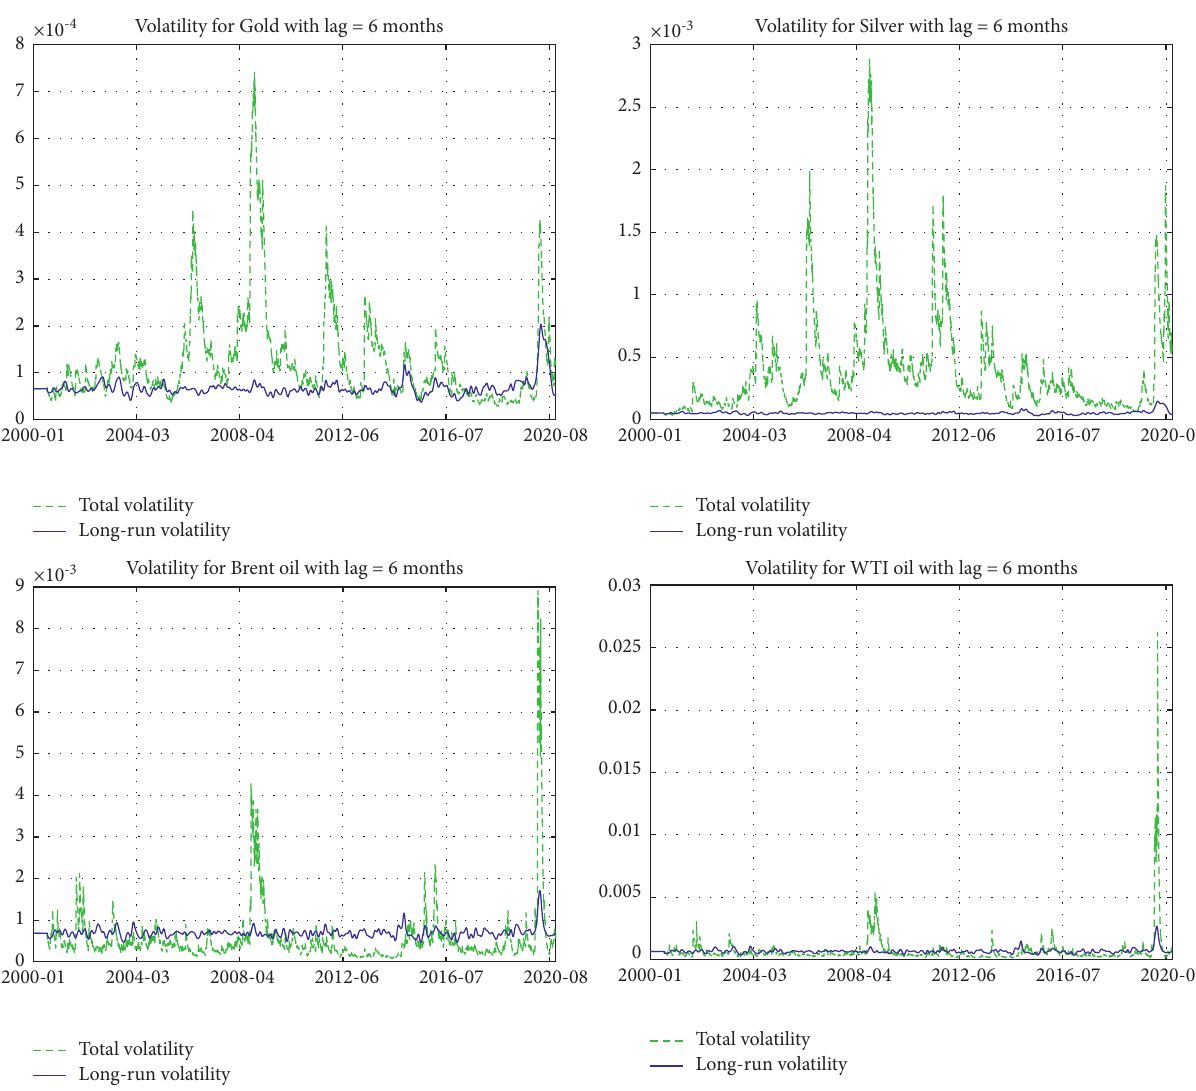
Figure 2: Estimated total and long-run volatility of precious metal and crude oil futures with GARCH-MIDAS +ID-EMV Table 2: Estimation results of GARCH-MIDAS +ID-EMV models of futures volatility by infectious disease with 3-month lags. Futures